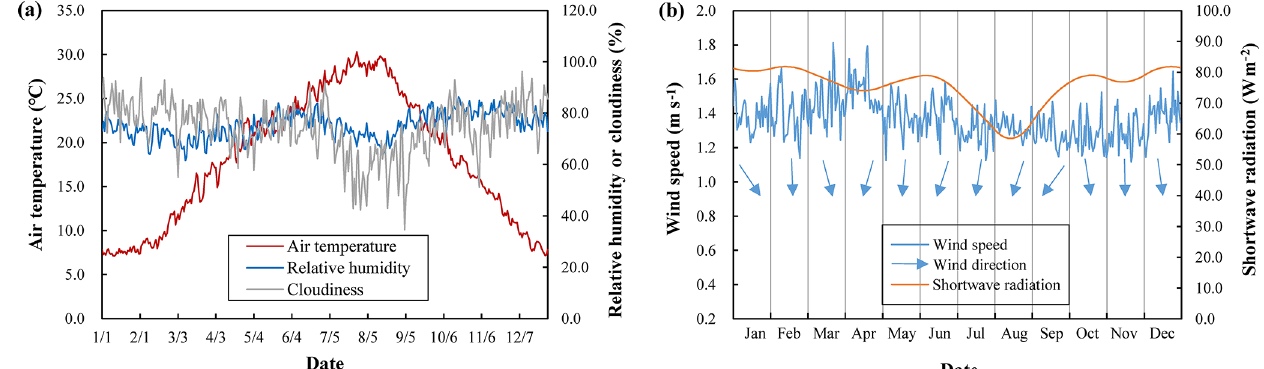
Figure 4. Meteorological conditions. (a) Daily average multiyear values of air temperature, humidity and cloudiness and (b) daily average multiyear values of wind conditions and shortwave radiation. Arrows in (b) indicate the wind direction, and the arrow pointing upward is defined as the direction of due